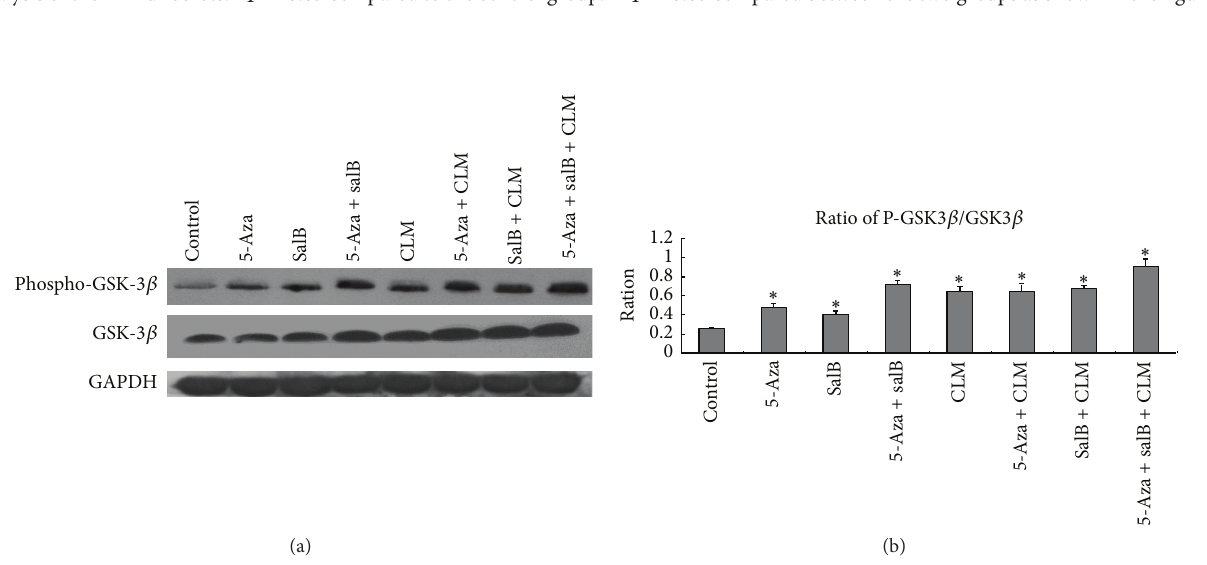
Figure 7: Phosphorylated GSK-3beta protein expression. (a) Phospho-GSK-3beta protein expression by Western blotting. (b) Phospho- GSK-3beta was quantified by densitometric analysis of the immunoblots. The group sequence from left to right is control group, 5-aza, SalB, 5-aza+SalB, CLM 5-aza+CLM, SalB+CLM, and 5-aza+SalB+CLM. ∗ 𝑃 < 0.05 compared to the control